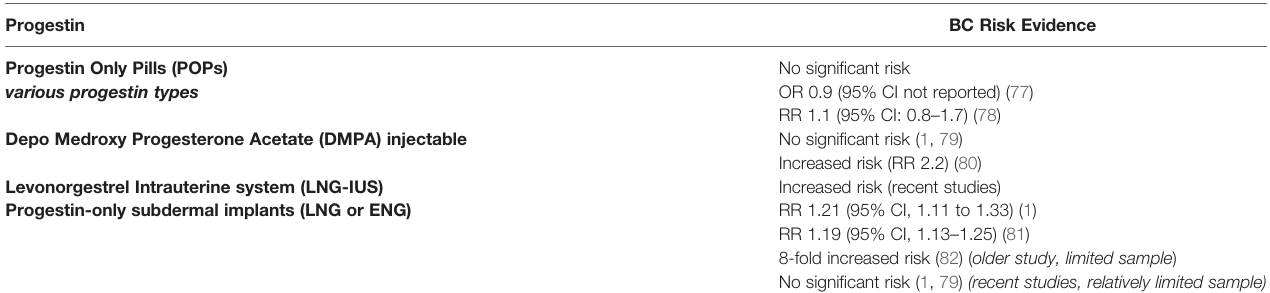
TABLE 3 | Summary of key evidence on BC risk with progestin-only contraceptives. Progestin BC Risk Evidence Progestin Only Pills (POPs) various progestin